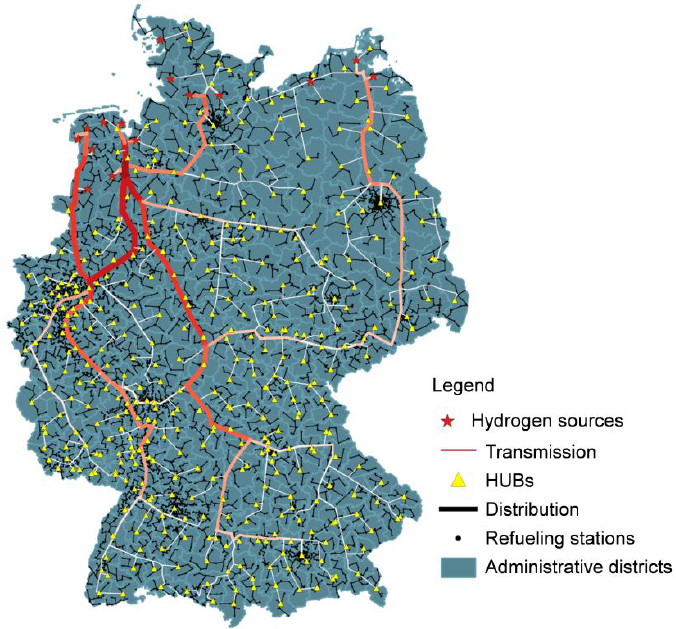
Figure 15. Dedicated hydrogen pipeline grid to supply 2.9 million tons of hydrogen from 28 GW installed electrolysis to 9968 hydrogen fuelling stations.